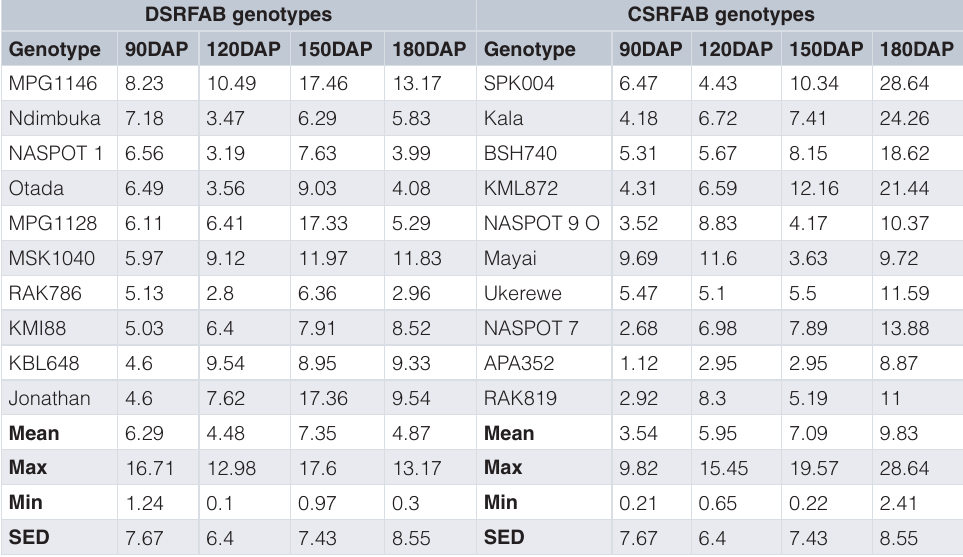
Table 7. Yield means of 10 most distinct discontinuous (DSRFAB) and continuous (CSRFAB) genotypes at different harvest times showing overall best yielding genotypes in combined